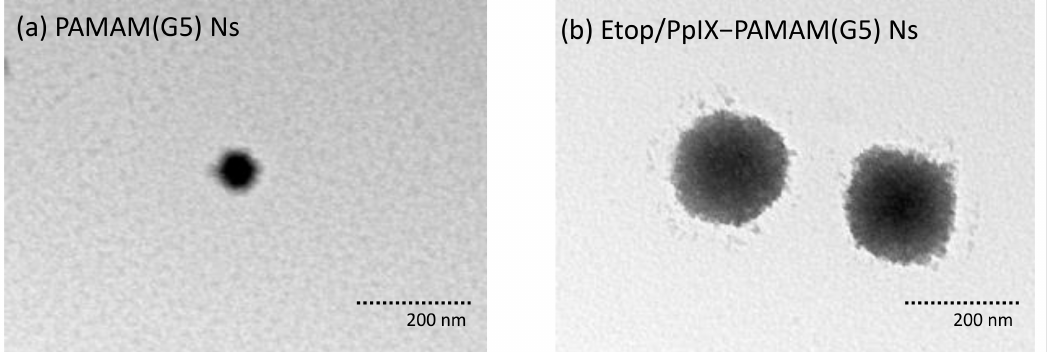
Figure 2. ( a ) TEM image of PAMAM(G5) Ns; ( b ) Etop/PpIX-PAMAM(G5) Ns at 200,000 × magnification. (Etop—etoposide, PAMAM(G5) Ns—generation-5 polyamidoamine dendrimer nanosphere, PpIX—protoporphyrin IX, TEM—transmission electron